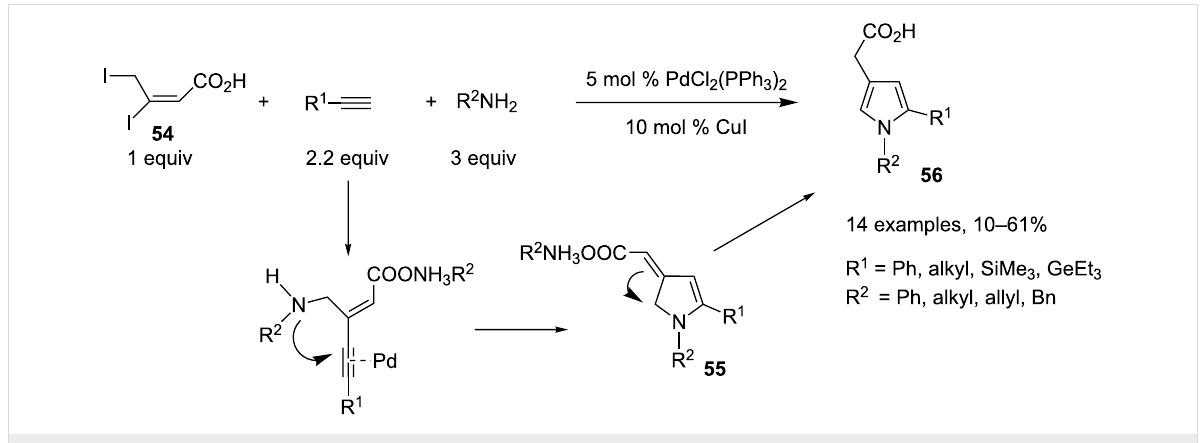
Scheme 25: Synthesis of pyrroles through an allylic amination/Sonogashira coupling/hydroamination